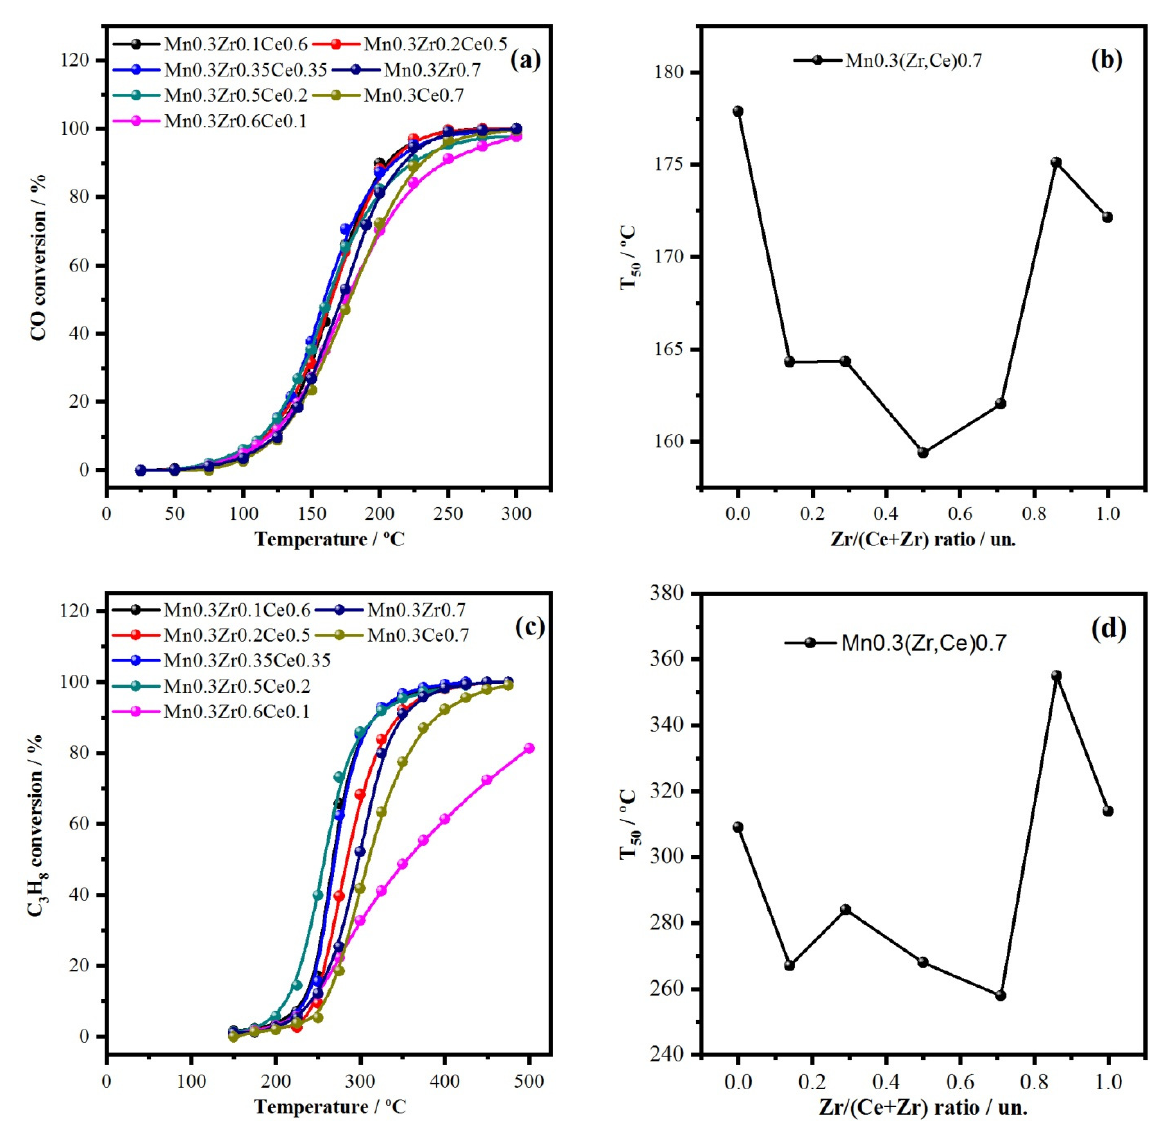
Figure 3. Reaction temperature dependence of ( a ) CO and ( c ) C 3 H 8 conversion; the molar ratio Zr/(Ce + Zr) dependence of T 50 for ( b ) CO and ( d ) C 3 H 8 conversion in oxidation reaction over Mn0.3(Zr,Ce)0.7 catalysts.